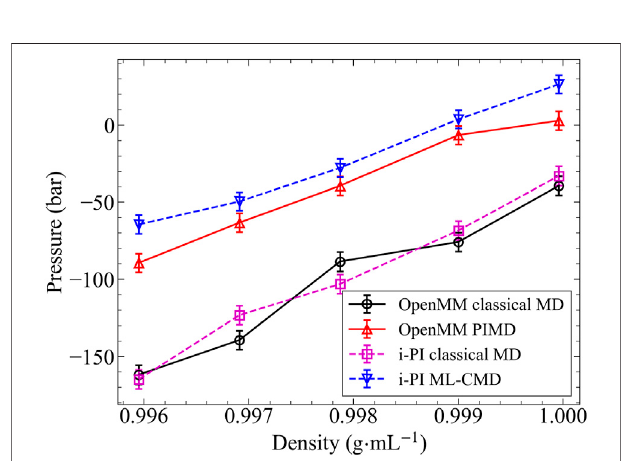
FIGURE 4 | The pressure varies with density in 300 K. This is an alternative pressure plot because the barostat behave difference in two different software. The black solid line: classical MD simulated by OpenMM. The violet dashed line: classical MD simulated by i-PI. The red solid line: PIMD simulated by OpenMM. The dashed blue line: ML-CMD simulated by i-PI This model is trained in 0.998 g/ml.